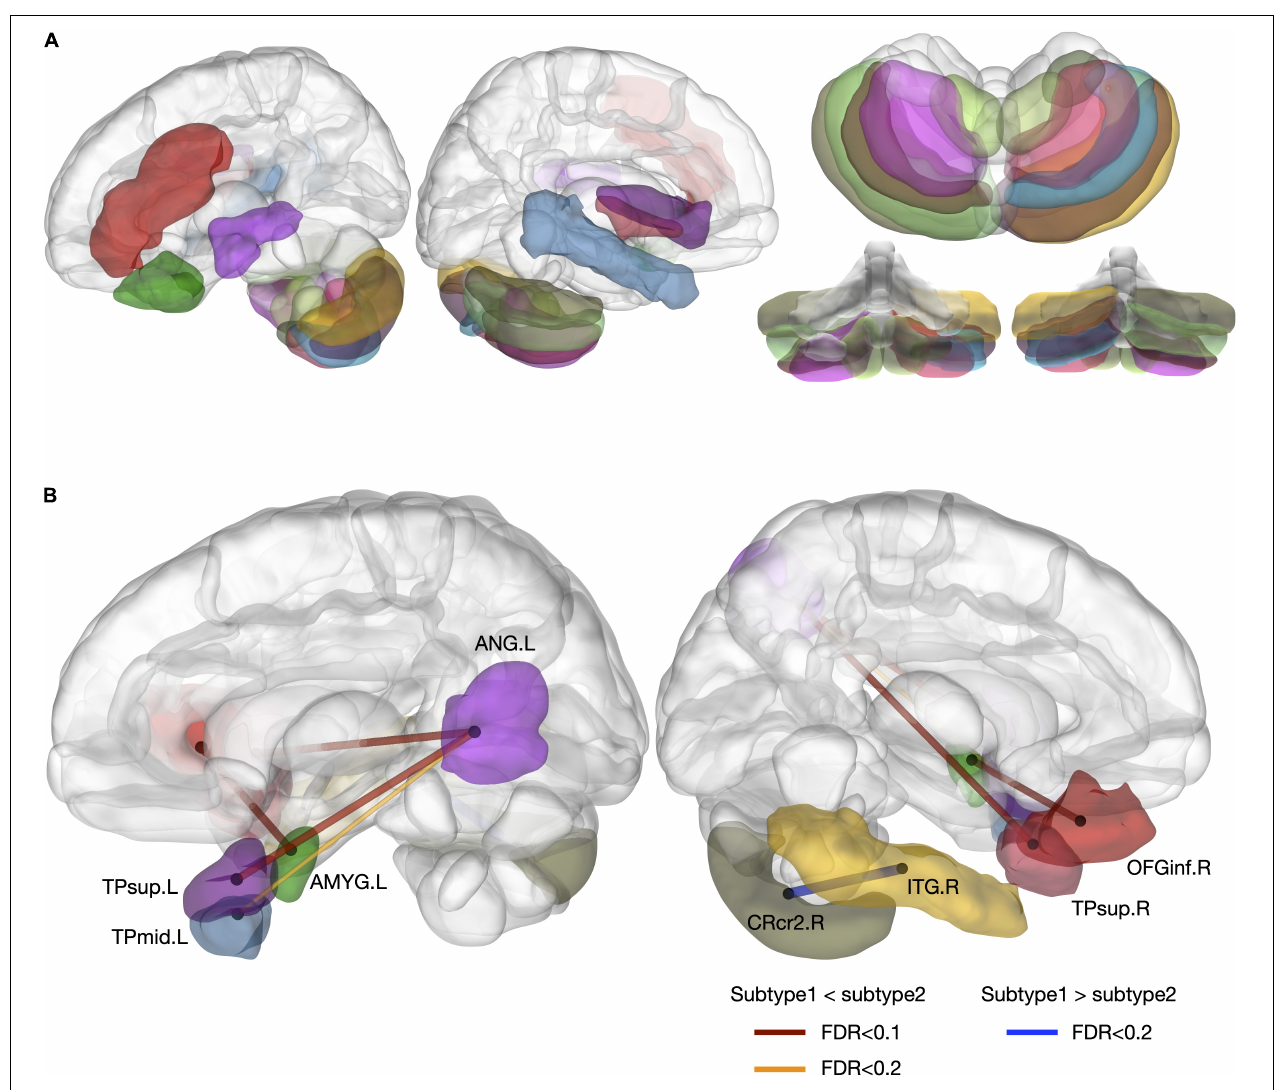
FIGURE 5 | Differences in regional volumes and structural covariance networks between SSD subtypes. (A) Regional volume difference was reduced in subtype 2, compared to subtype 1 (FDR < 0.2). (B) Different structural covariance patterns between the two subtypes (FDR < 0.2). TPsup, superior temporal pole; AMYG, amygdala; ANG, angular gyrus; CRcr2, cerebellar crus 2; ITG, inferior temporal gyrus; OFGinf, inferior orbitofrontal gyrus; L, left; R,